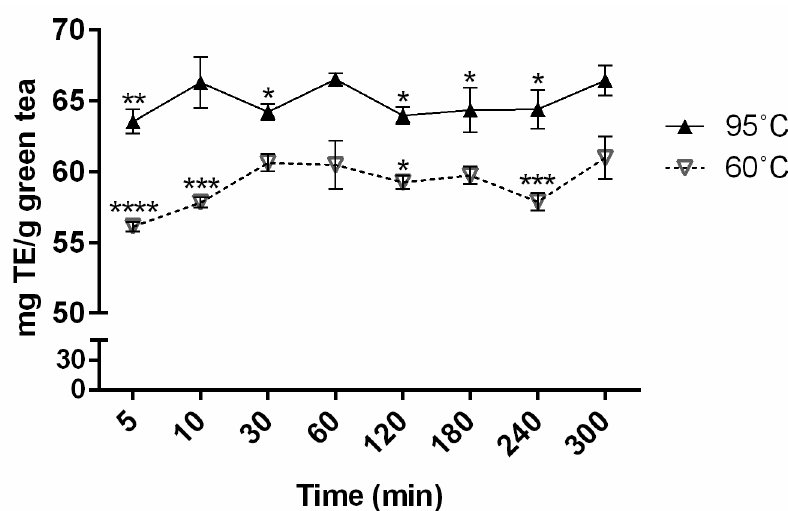
Figure 1. DPPH free radical scavenging activity of green tea infusions brewed at 60 ◦ C and 95 ◦ C for 5–300 min. Each time point was compared with 300 min and 60 min for 60 ◦ C and 95 ◦ C, respectively. *, **, ***, and **** indicate p < 0.05, p < 0.01, p < 0.001, and p < 0.0001, respectively. All comparisons between 60 ◦ C and 95 ◦ C at the same time point were statistically significant ( p < 0.001 for 5 min and 120 min; and, p < 0.01 for 10 min, 30 min, 60 min, 180 min, 240 min, and 300 min.).